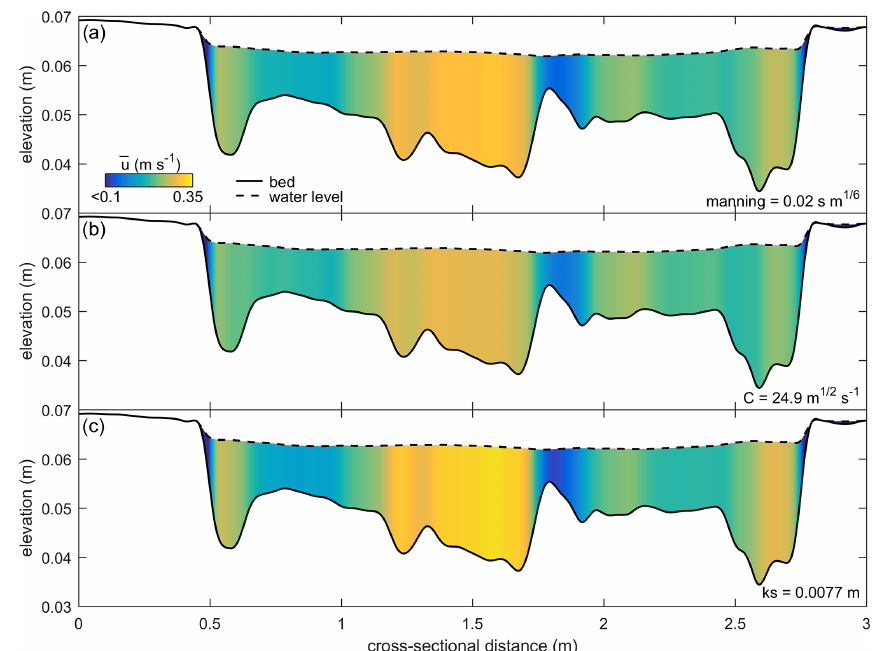
Figure 11. Effect of different hydraulic roughness predictors on the distribution of depth-averaged flow velocity u for (a) a constant Manning, (b) a constant Chezy C and (c) a constant grain roughness k s (White–Colebrook). The cross section is from the experimental estuary by Leuven et al. (2018) at x = 15 . 3m at maximum tilt in the ebb direction. Cross-sectional flow velocities were iterated for C and k s assuming the same total discharge and water levels as modelled in this study with